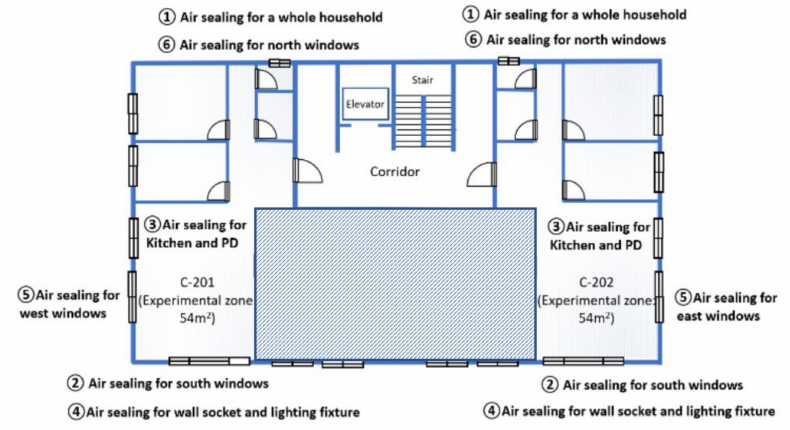
Figure 3. Removal sequence of the air tight tapes and membranes from the infiltration routes.